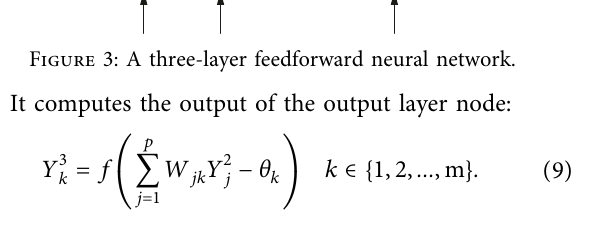
Figure 1: Neuron